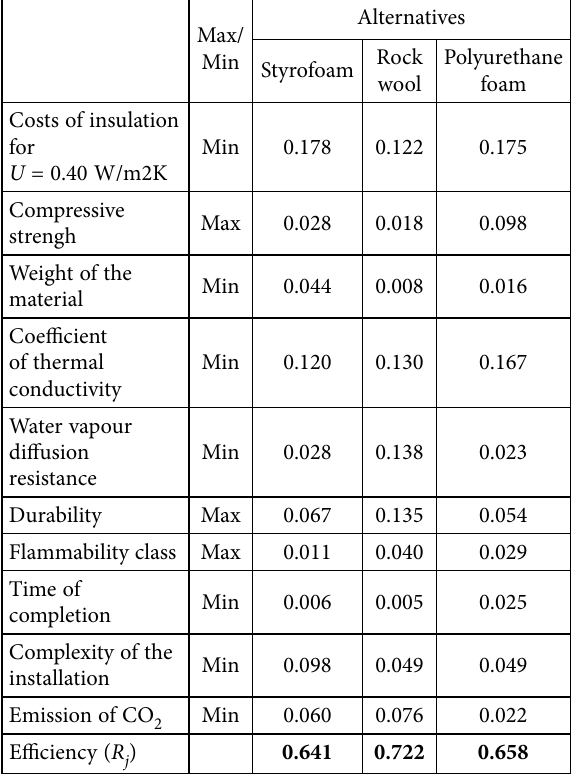
Table 5. Weighted decision-making